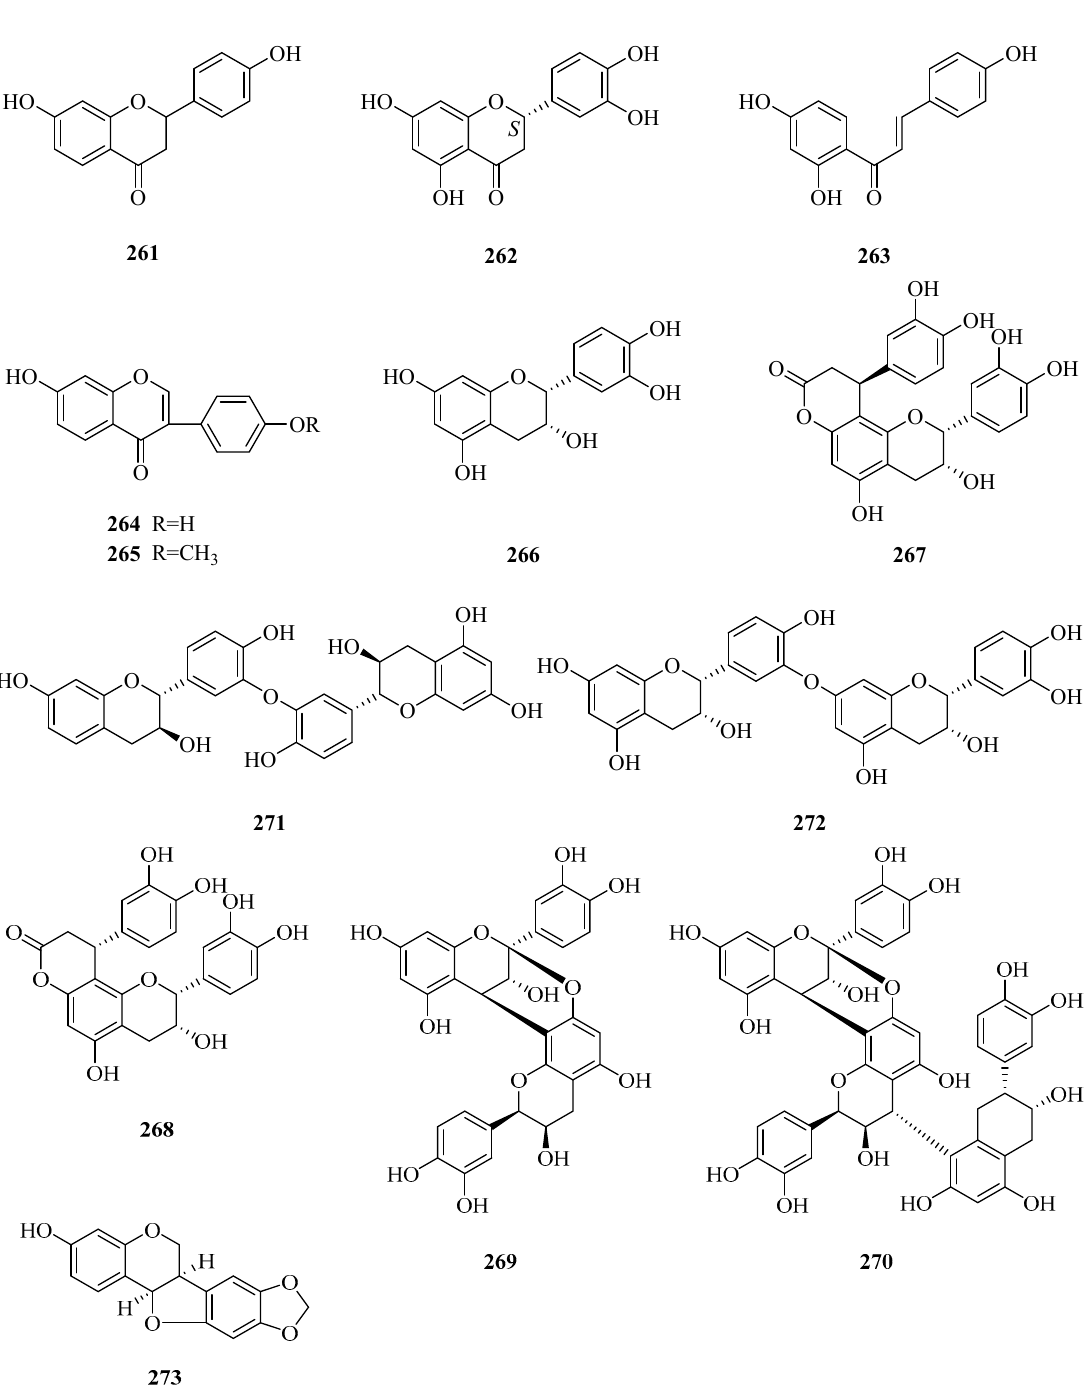
Table 7. Quinones from the genus Periploca .